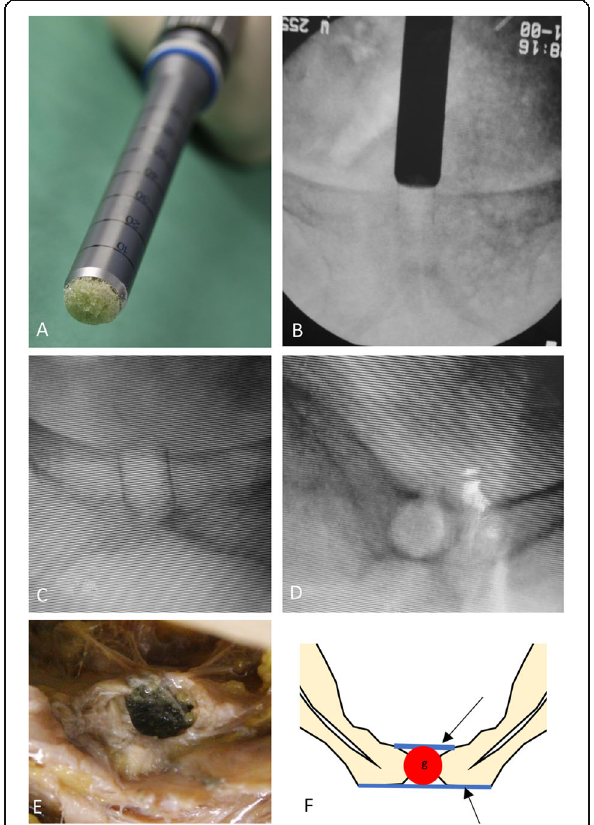
Fig. 3 a The Synbone cylinder for transplantation inside the harvesting device. b Radiograph showing the Synbone cylinder being pushed press-fit into the pubic symphysis c & d : Radiograph showing the transplanted cylinder inside the pubic symphysis e After dissection of the cranial part of the soft tissue shows remaining anterior and posterior ligaments of the pubic symphysis. f Schematic drawing of the pubic symphysis with the ligaments anterior and posterior still intact with the bone cylinder press-fit inside the pubic